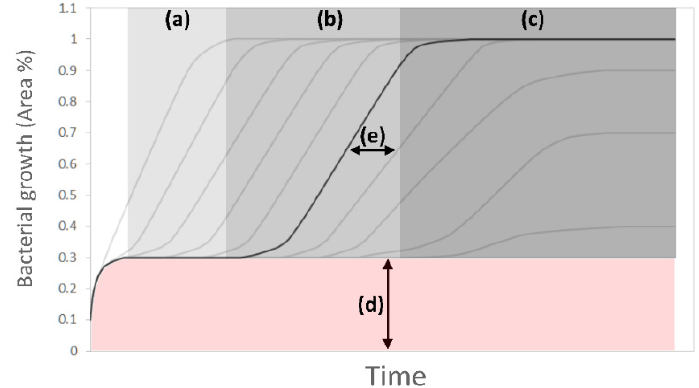
Figure 6. Bacterial growth model. Representation of bacterial growth calculations for different segments (gray lines). For the described segment in black: ( a ) lag phase, ( b ) exponential phase, ( c ) stationary phase, ( d ) image analysis offset, ( e ) between segment lag time.